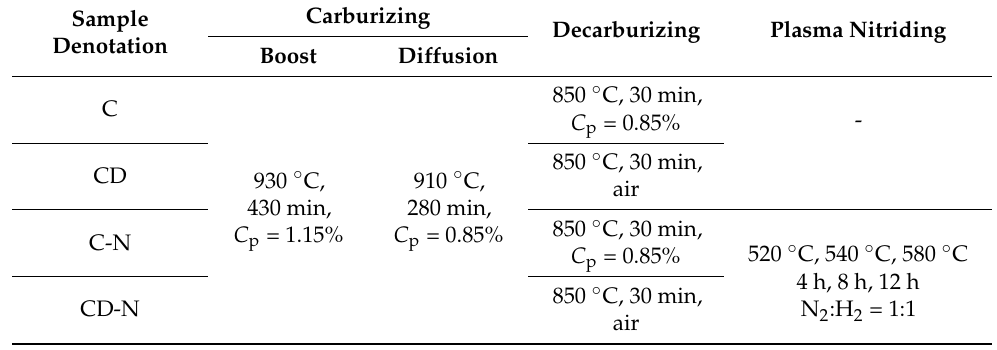
Table 1. Duplex process for M50NiL.